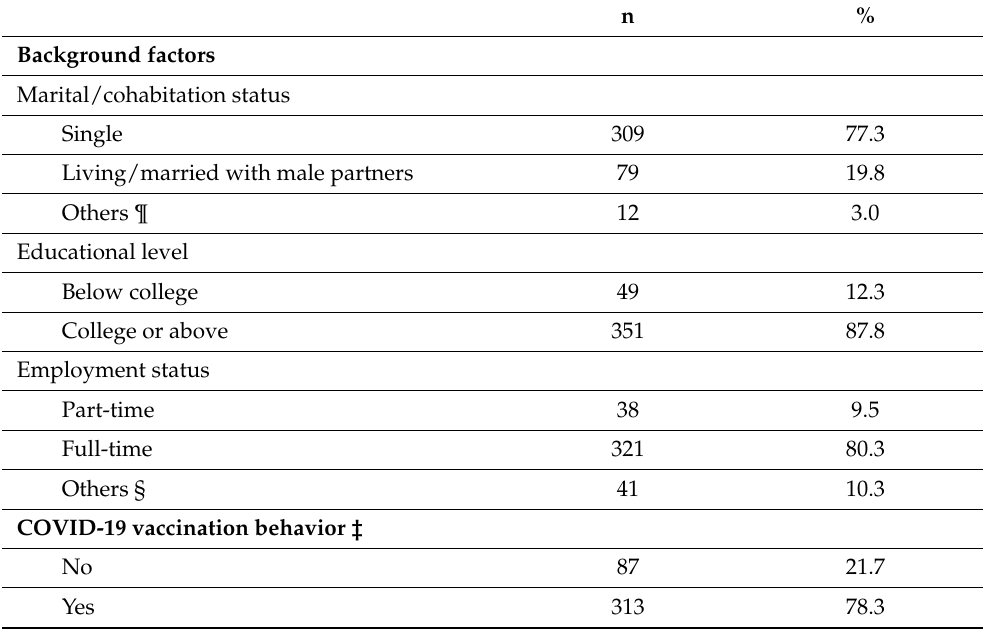
Table 1. Descriptive statistics of the categorical variables (n = 400).